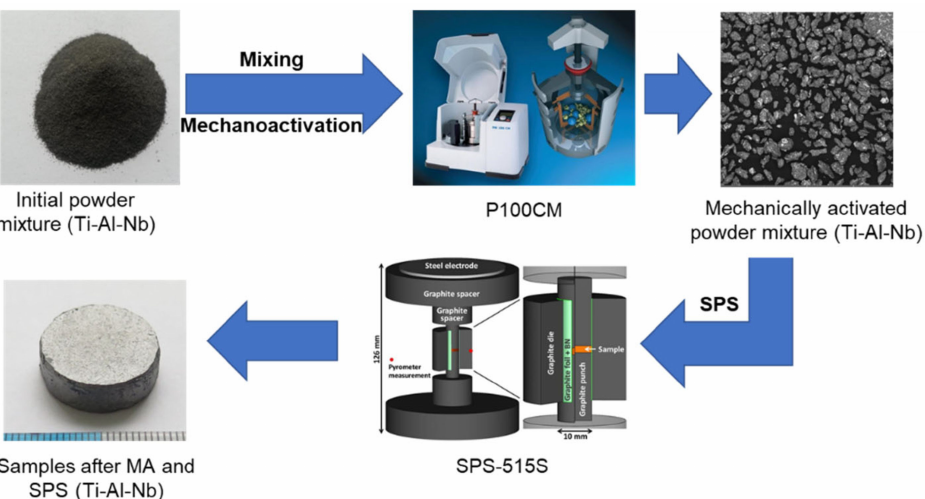
Figure 1. Scheme of combining technological processes of SPS to obtain IMC of the Ti-Al-Nb